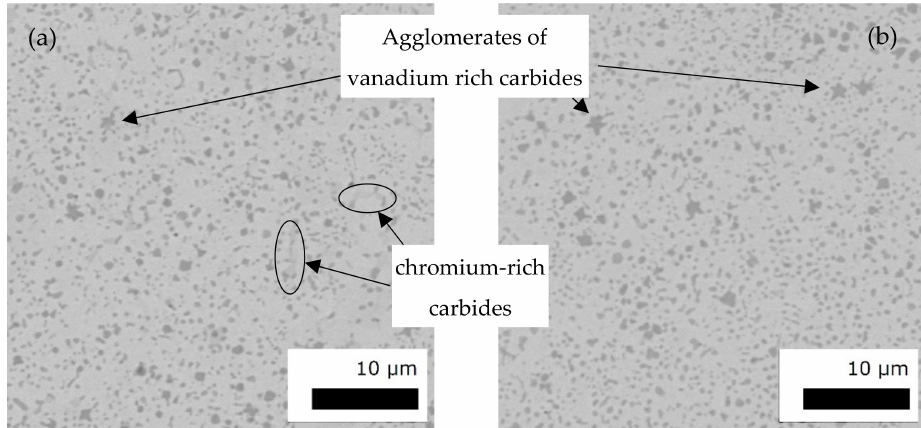
Figure 5. BSD of a cutting crown in as-built state ( a ) and after heat treatment ( b ) presenting a nearly dense and crack free microstructure with a hardness of 570 HV10 and 630 HV10,